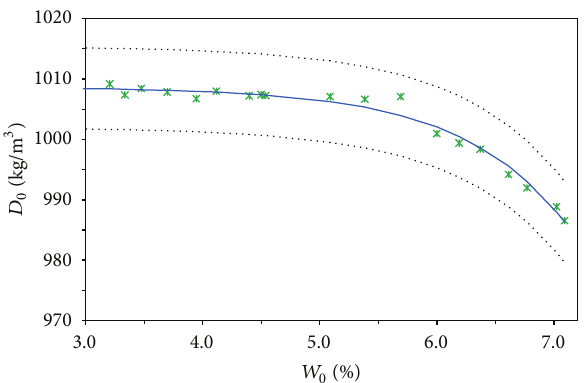
Figure 6: Fill density ( 𝐷 0 ) as a function of the powder moisture content ( 𝑊 0 ) with CI 95 %